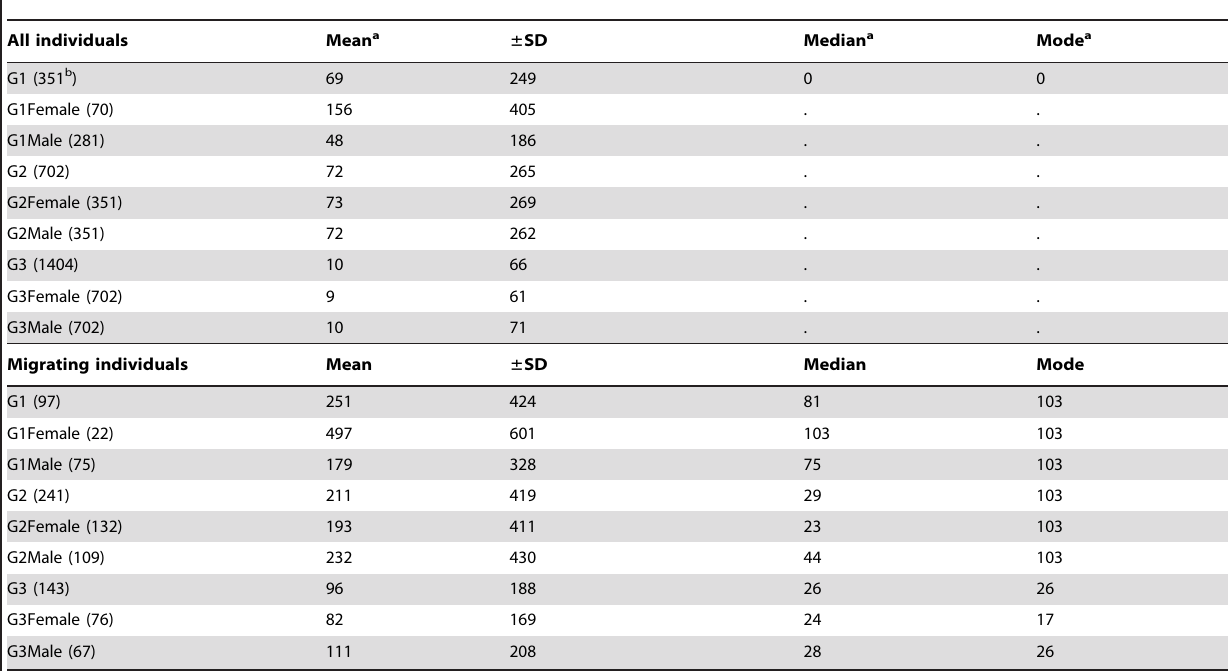
Median and mode for ‘‘All individuals’’ was zero for all groups. a Distances in